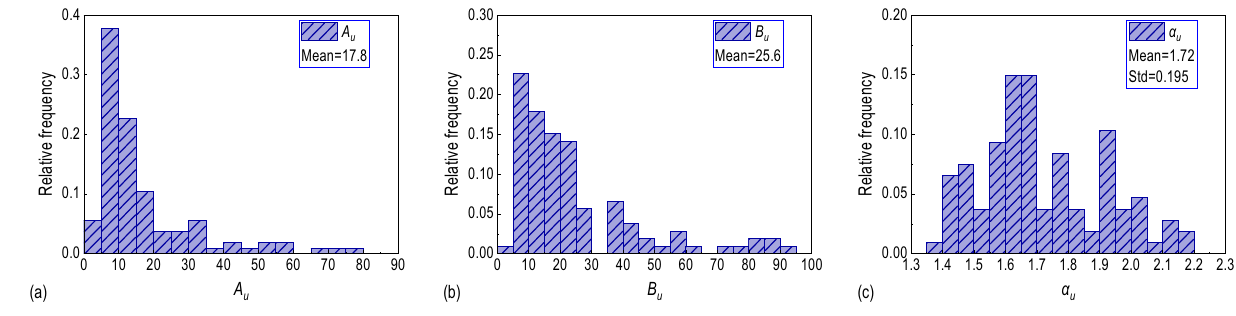
Figure 8. The frequency distribution histogram of the fitting parameters: ( a ) A u , ( b ) B u , ( c ) α u